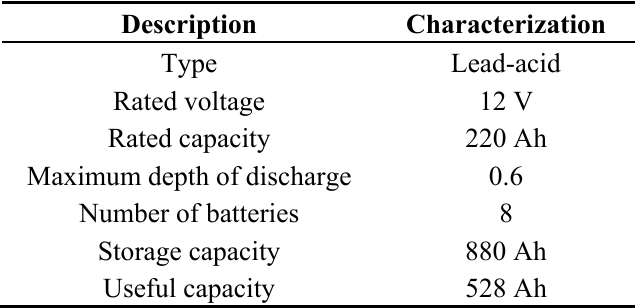
Table 3. Description and characterization of batteries.